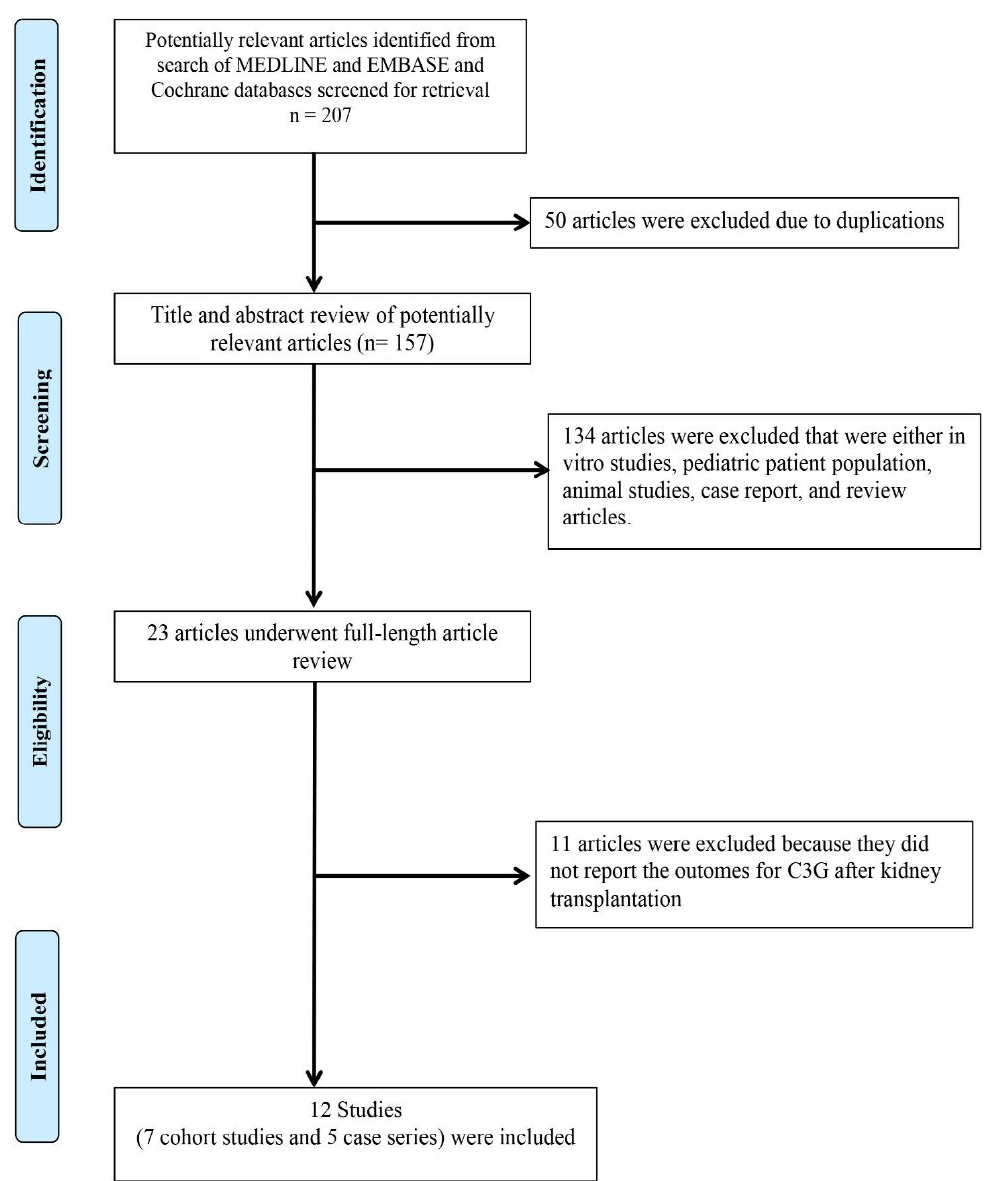
Figure 1. PRISMA flow diagram for study selection.